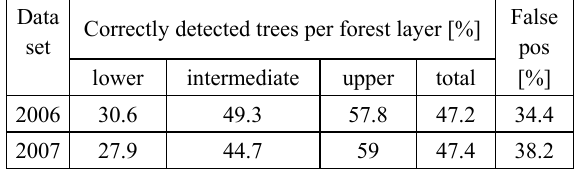
Table 4. 3D Detection of single trees in the sample plots